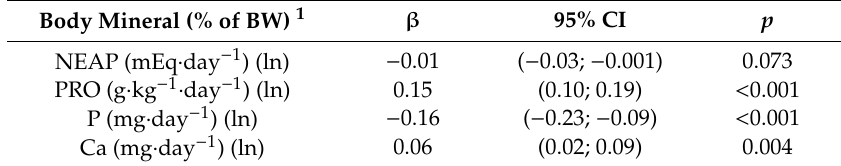
Table 7. E ff ects of athletes’ NEAP, protein, phosphorus, and calcium consumption on their body mineral content (% of BW). Body Mineral (% of BW) 1 β 95%